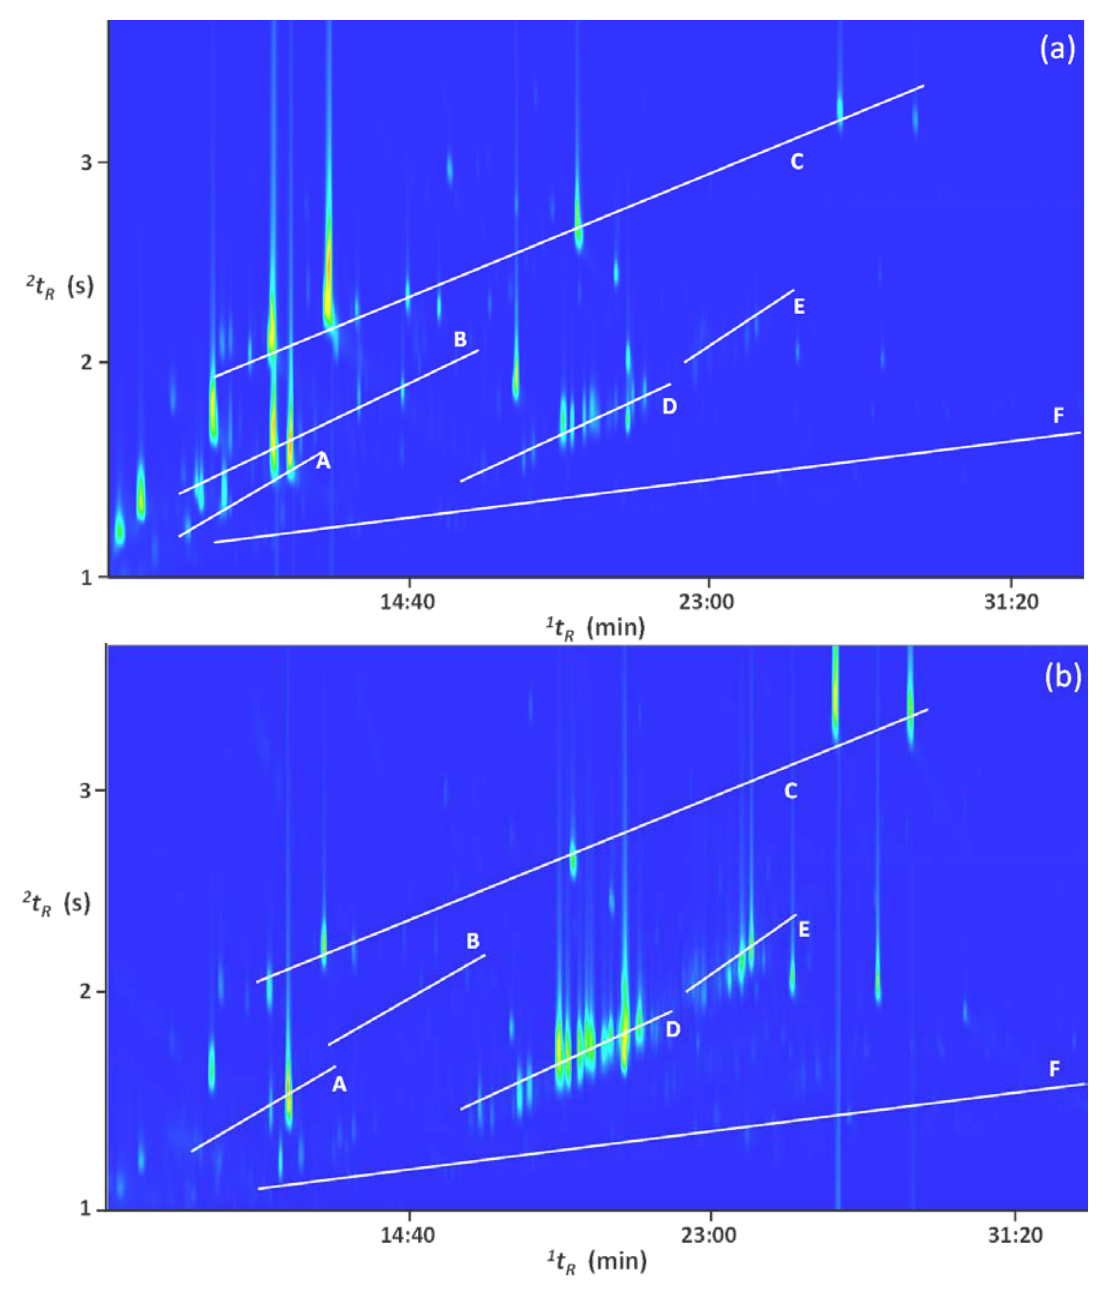
Figure 3. GC×GC total ion chromatogram (TIC) contour plots of two distillate fractions ( a ) collected after 25 min (fraction 1) and ( b ) after 8 h (fraction 4) of distillation of mature ylang-ylang flowers harvested in Mayotte. Letters A, B, C, D, E, and F correspond to monoterpenes, oxygenated monoterpenes, esters, sesquiterpenes, oxygenated sesquiterpenes, and alkanes,